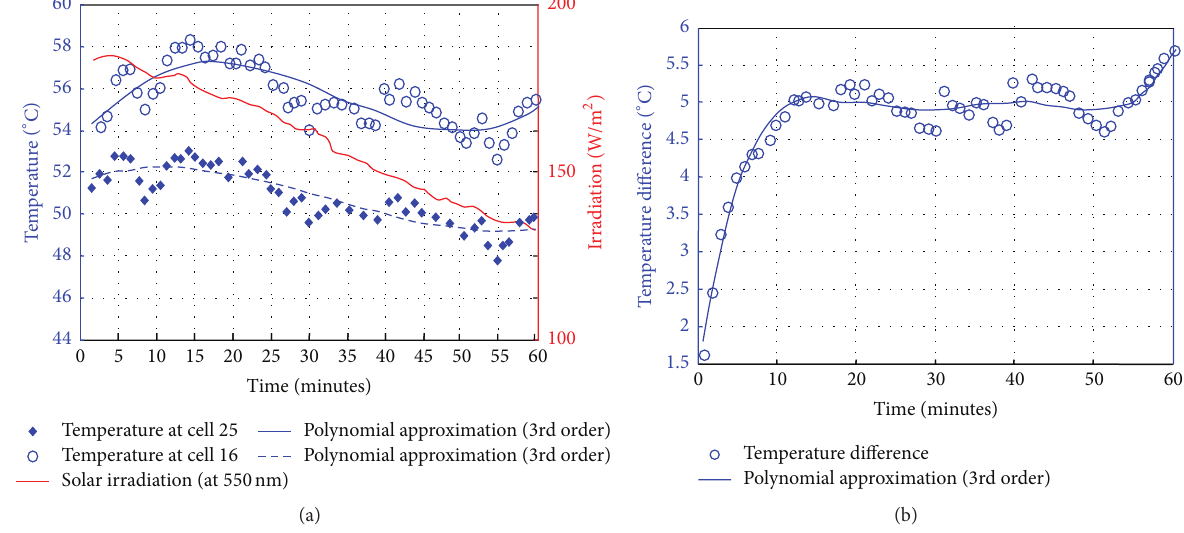
Figure 6: Thermal transient of screens 16 and 25 of module A. (a) For a small current step up. (b) Temperature difference.